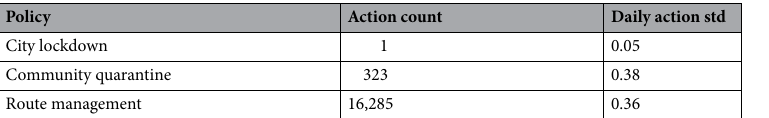
Table 1. Statistical comparison of the complexity of city lockdown, community quarantine, and route management. The computation of daily action Std is detailed in “Experiment settings”